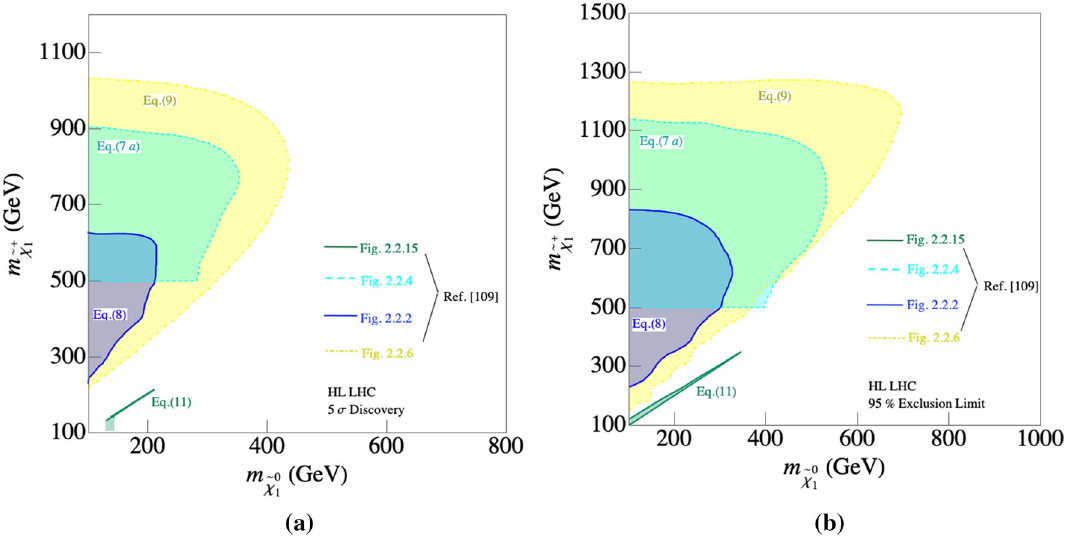
- m ˜ χ ± plane at the HL-LHC. The color coding for 1 1